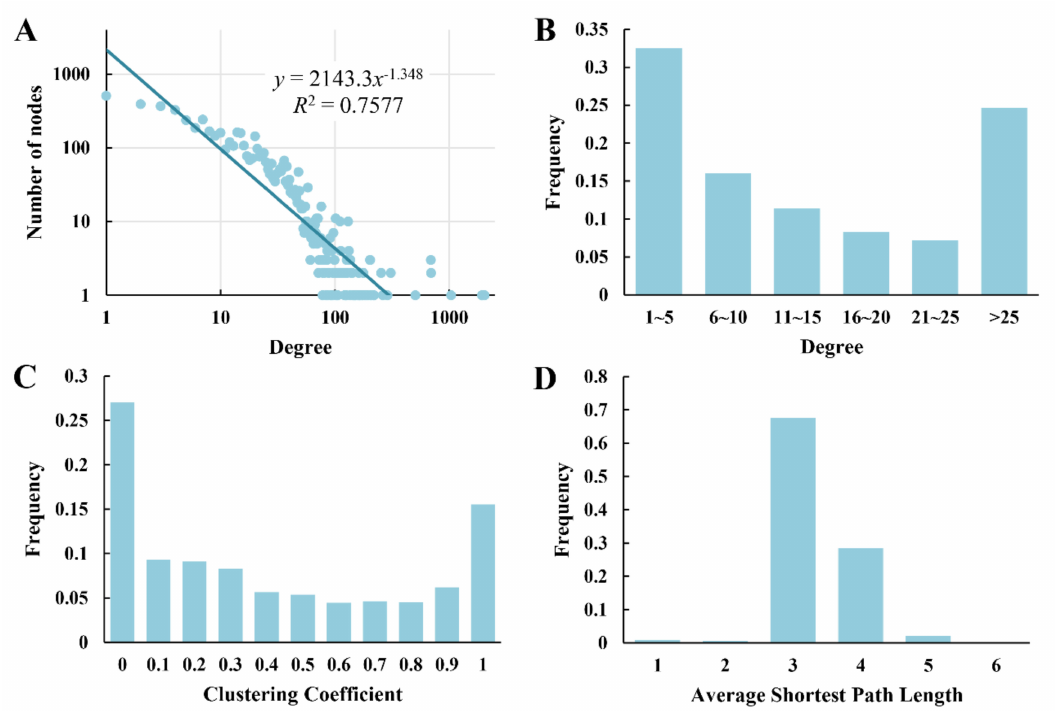
Figure 3. Distributions of topological properties of the B. diazoefficiens USDA110 PPI